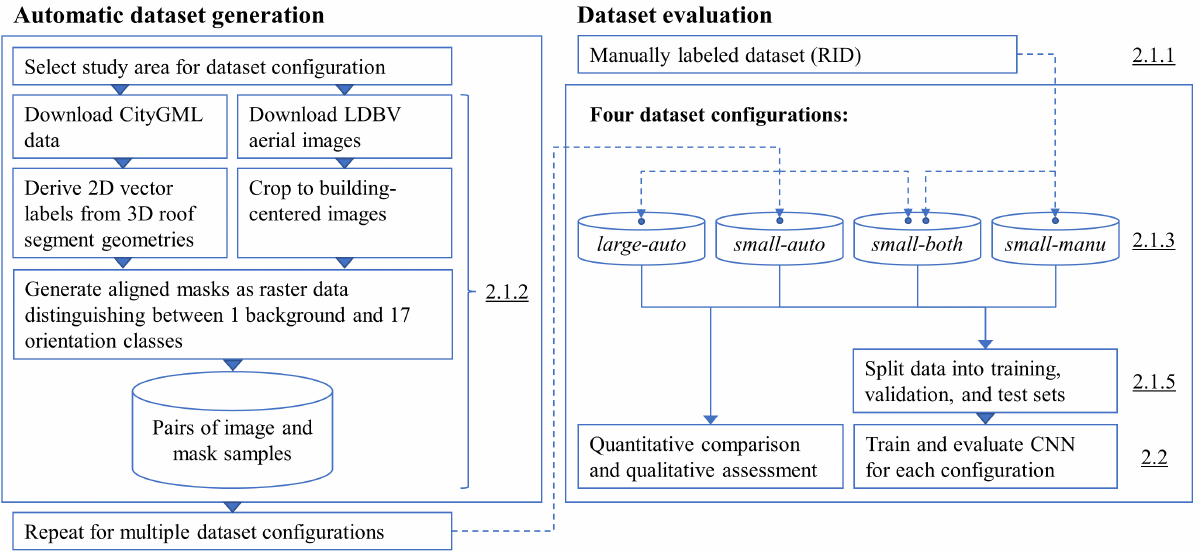
Figure 1. A graphical representation of the methodology used in this study. Numbers to the right point to the respective sections in this article where further details can be